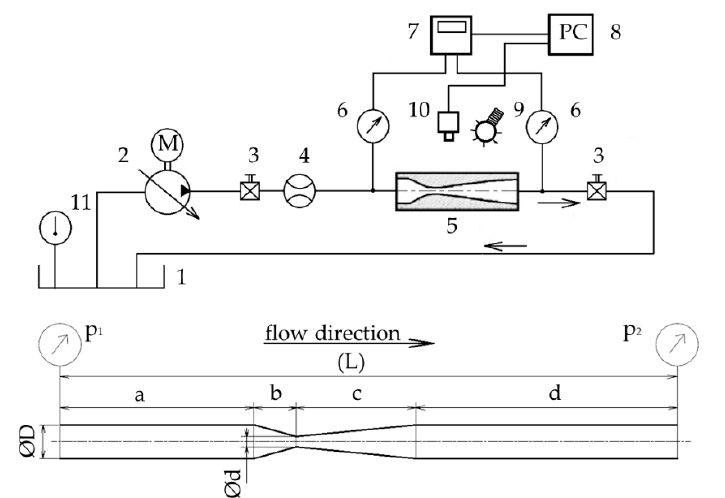
Figure 3. Measuring equipment and basic dimensions (mm): (1) tank; (2) hydro generator/pump; (3) ball valve; (4) flowmeter; (5) convergent-divergent nozzle; (6) pressure sensors; (7) evaluating and recording equipment; (8) computer; (9) light; (10) high speed camera; (11) thermometer. The ball valves were included in the circuit to control flow. In the case of a water line,